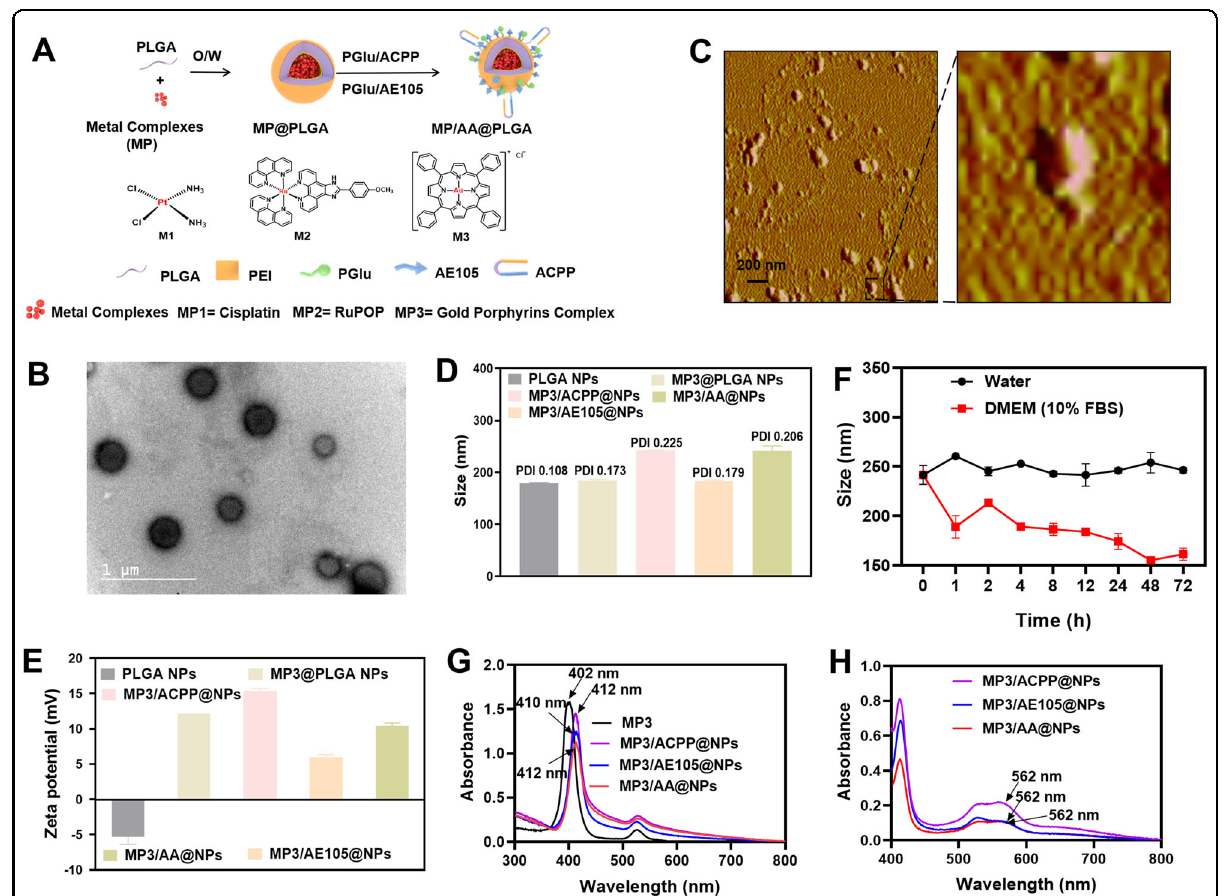
Fig. 1 The synthesis and characterization of nanoparticles. A Synthetic illustration of MP/AA@NPs, B TEM, and C AFM image of MP3/AA@NPs. D The size and E the zeta potential of PLGA NPs, MP3@PLGA NPs, MP3/ACPP@NPs, MP3/AE105@NPs and MP3/AA@NPs. F The size change of MP3/ AA@NPs after incubation with water and DMEM (10% FBS). UV – vis spectra of MP3, MP3/ACPP@NPs, MP3/AE105@NPs and MP3/AA@NPs ( G ) before and ( H ) after incubation with the BCA